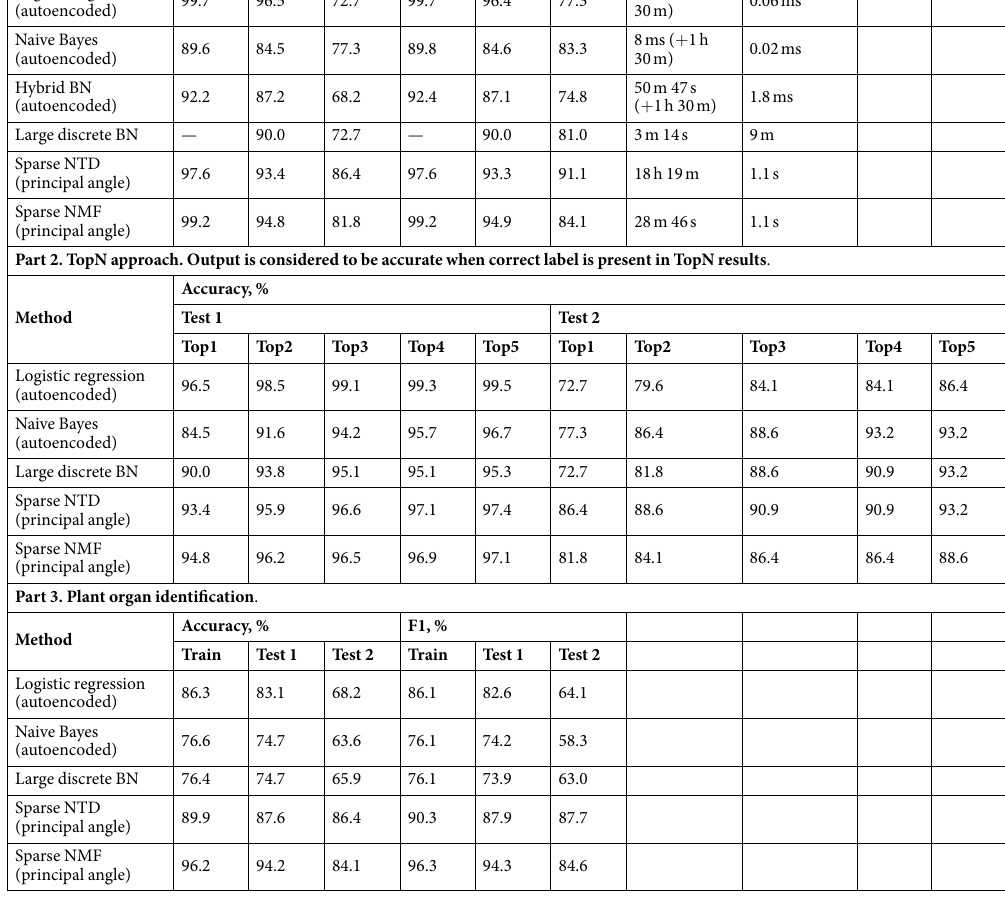
Table 1 . Comparative characteristics of implemented approaches. Test 2 is independent from Train/Test 1 parts. In Part 1 and Part 3 all values presented are medians across 5-times repeated 5-fold cross validation runs. In Part 2 the same partitioning was used but final results were computed as top-N’s (see Supplementary